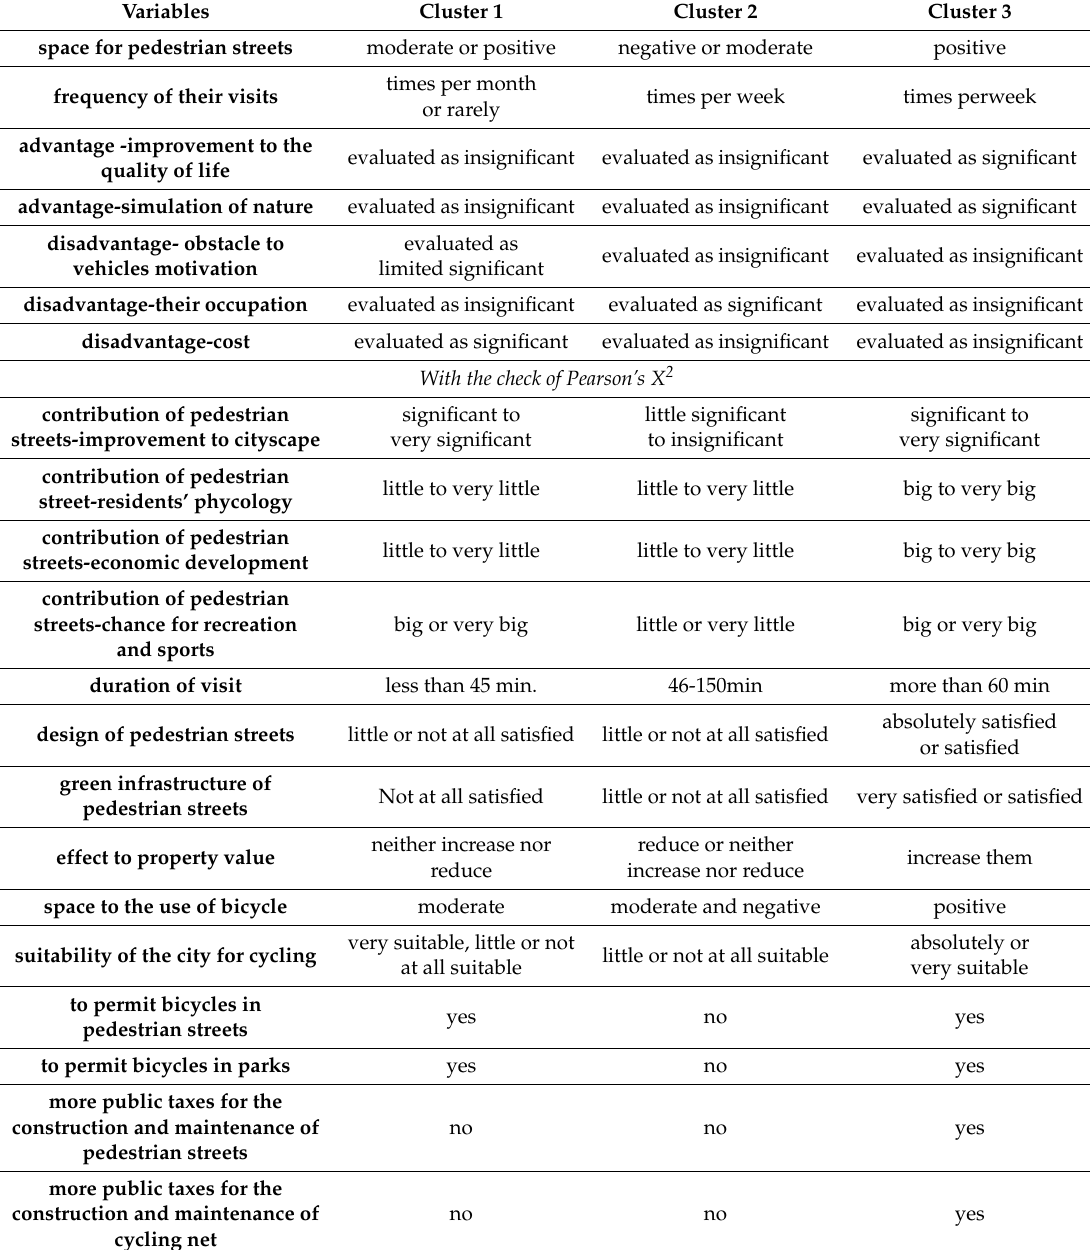
Table 4. Interpretation of the clusters’